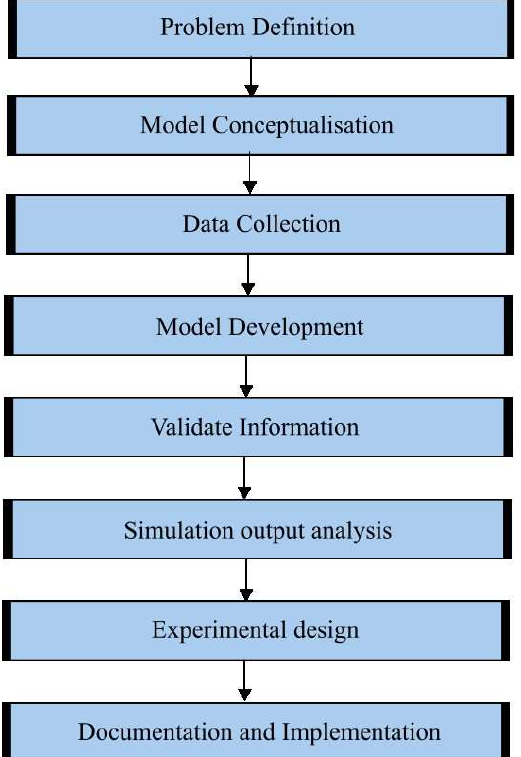
Figure 2. Simulation steps for the development of model [44]. Table 2. Scenario 1 and scenario 2